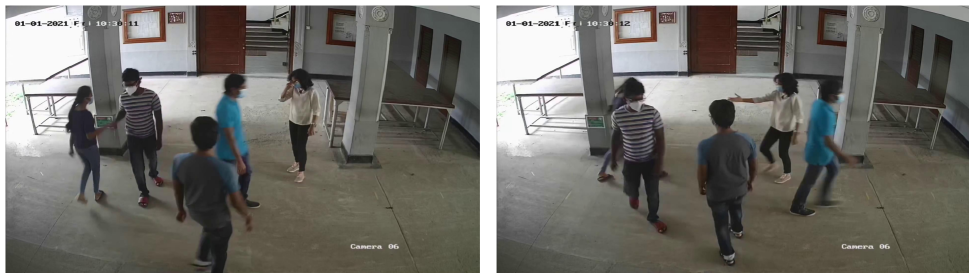
Figure 5. Example frames that were removed from full system evaluation due to disparity in human expert